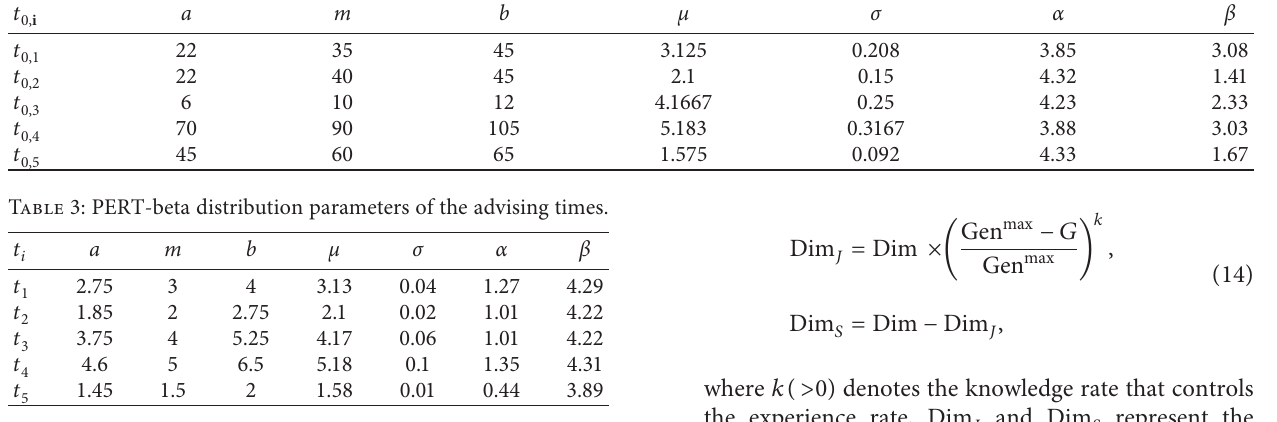
Table 2: PERT-beta distribution parameters of the travelling times from the starting location. t m 0 , i